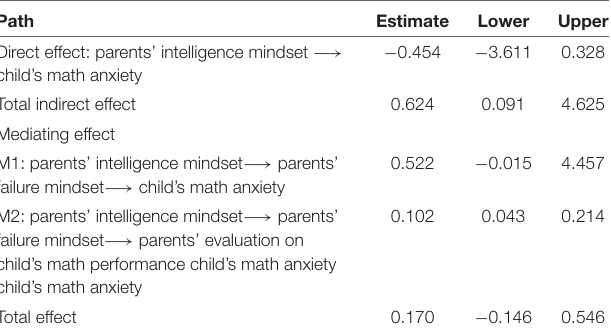
Table 4 , Model 1 has no constraint on the model parameters; Model 2 constrains the factor loadings to be equal; and Model 3 constrains the intercepts to be equal. All three models